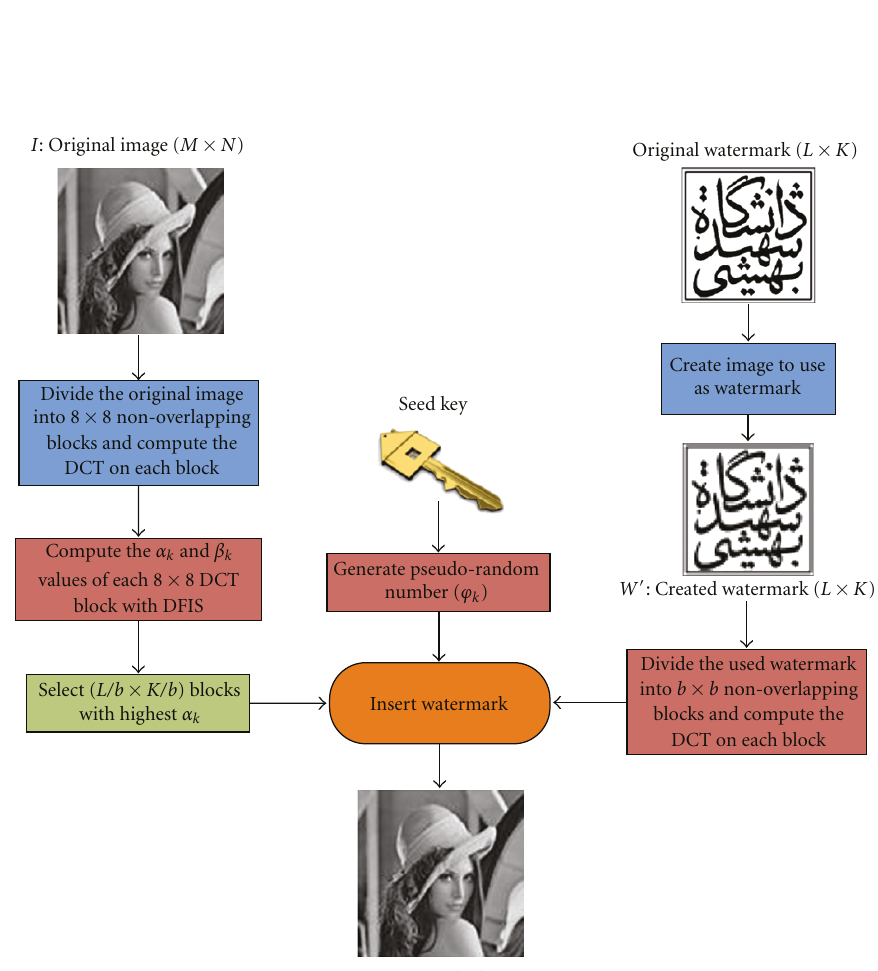
Figure 8: The proposed watermark embedding